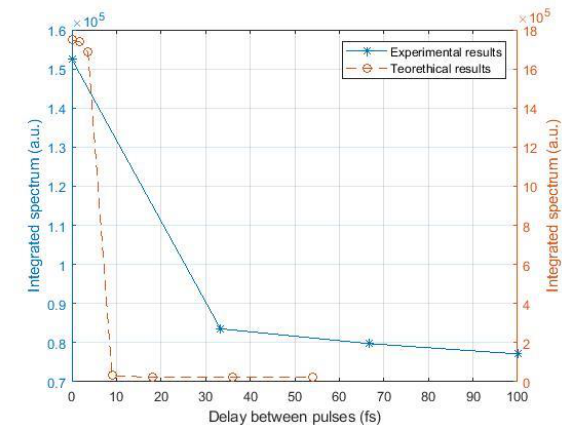
Fig. 3. Comparative between theoretical and experimental results for integrated output spectrum at different delay